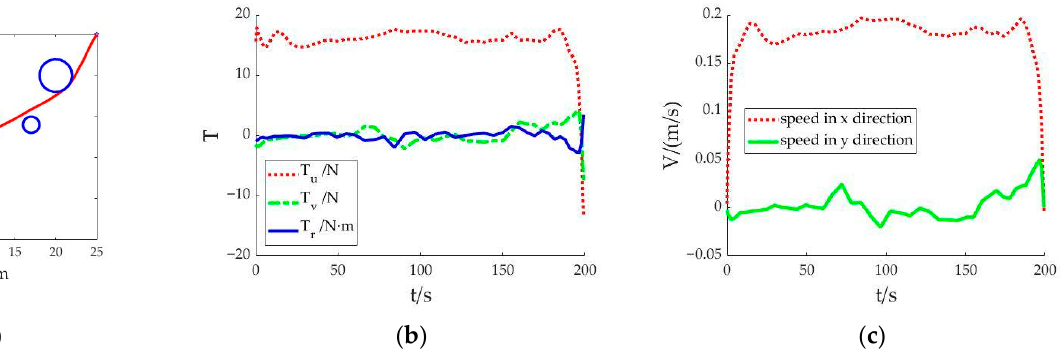
Figure 4. Result of each state in scenario 3: ( a ) Trajectory planning of the AUV; ( b ) Variation diagram of thrust; ( c ) Diagram of velocity change in x and y directions.